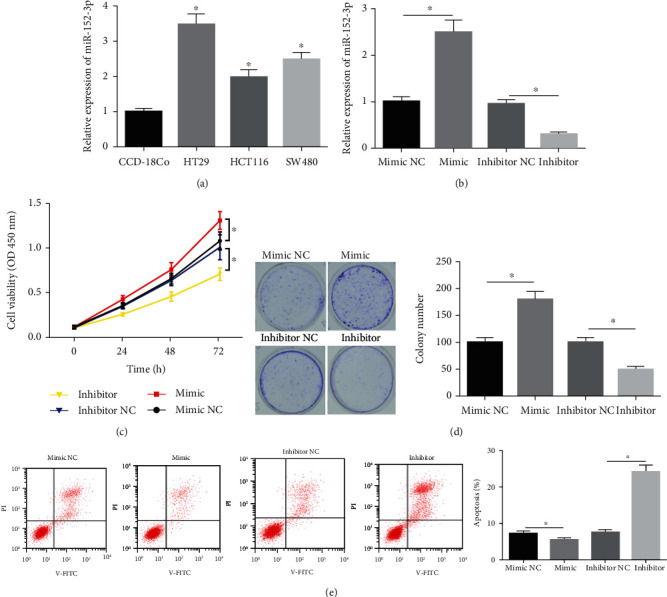
miR-152-3p is upregulated in colon cancer cells and affects cancer cell proliferation and apoptosis. miR-152-3p was significantly increased in (a) colon cancer cell lines HT29, HCT116, and SW480 relative to the normal cell line CCD-18Co. (b) qRT-PCR, (c) CCK-8, (d) colony formation assay, and (e) flow cytometry were conducted to assess the expression of miR-152-3p, cell viability, colony-forming ability, and apoptosis in each treatment group (∗ means p < 0.05).